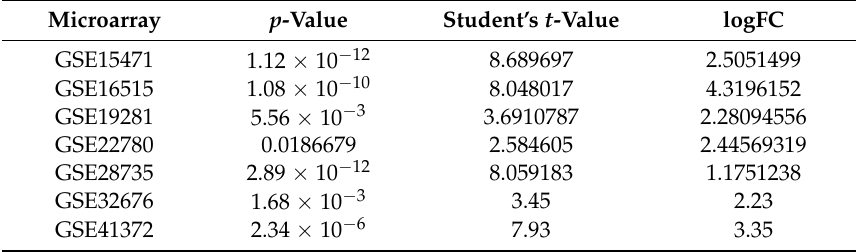
Table 1. The expression levels of GPRC5a in seven microarray datasets. Compared with normal pancreas tissues, the expression level of GPRC5a was upregulated in pancreatic cancer tissues ( p -value < 0.05 and logFC < −